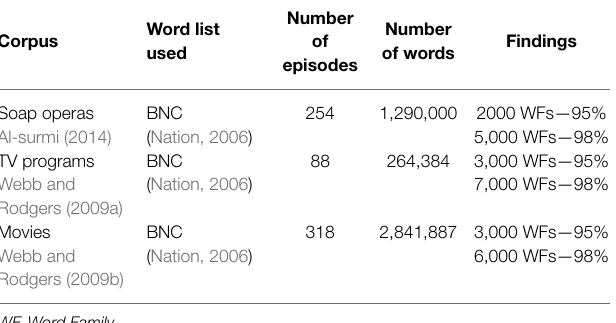
TABLE 1 | A summary of past studies on the vocabulary demands of soap operas, TV programs, and movies.